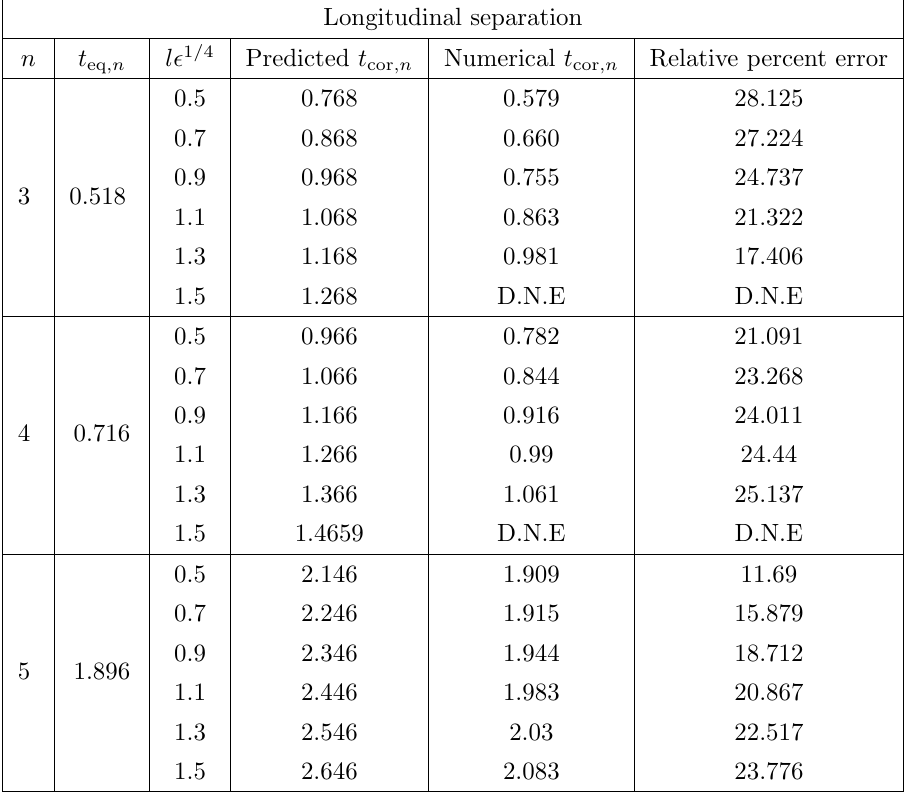
, and 2-point functions, t cor , ,n ,n = 1 B